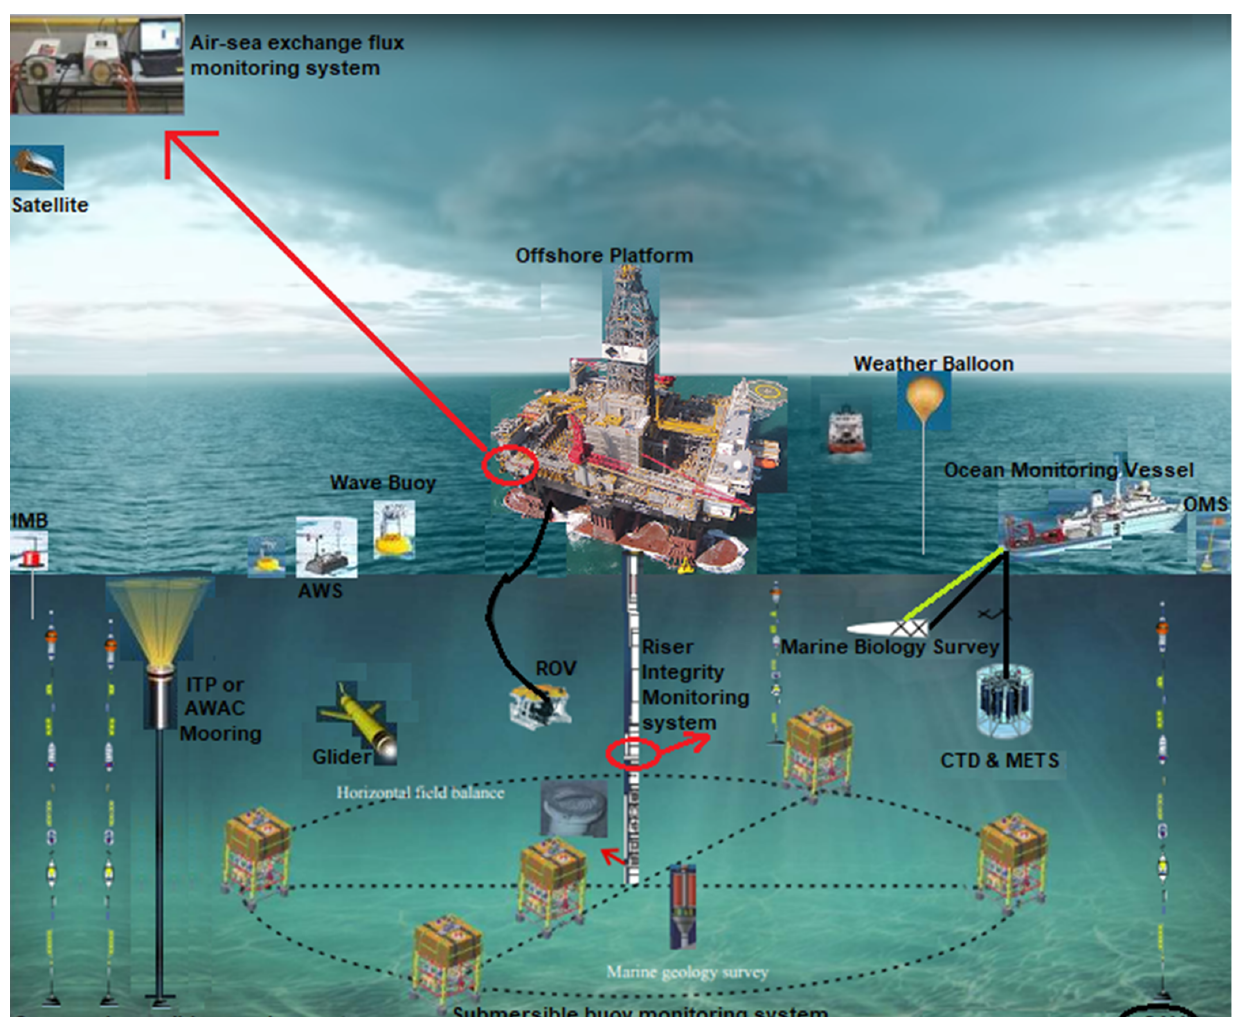
Figure 1. Different monitoring systems that are used on an offshore production asset, showing ocean submersible monitoring systems, submarine buoy monitoring systems, remotely-operated vehicle (ROV), conductivity-temperature-depth (CTD) instrument, air–sea exchange flux monitoring systems, ice mass-balance buoy (IMB), Ocean Monitoring System (OMS), weather balloon, satellite, etc. (Image Credit: Author 1-C.V.A.).